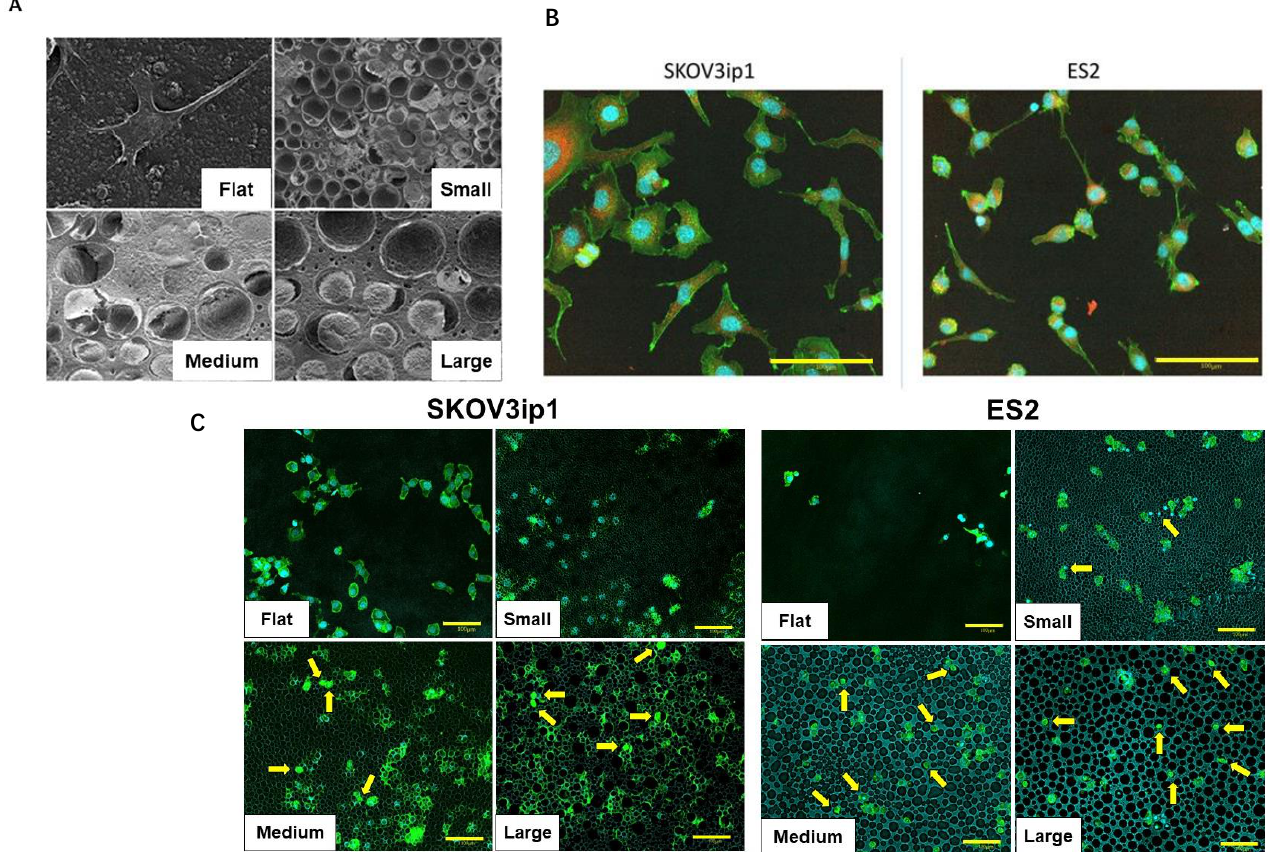
Figure 3. SEM and CLSM images of ovarian cancer cell lines. ( A ) SEM images of SKOV3ip1 cells morphologies on the flat films (Flat), films with a pore size of 5–8 µ m (Small), 8–12 µ m (Medium), and 12–16 µ m (Large). ( B ) CLSM images of SKOV3ip1 and ES2 cells showed the merged staining for the nucleus (blue), actin (green), and vinculin (red). All scale bars (yellow line) are 100 µ m. ( C ) The numbers of cells settled into the pores in SKOV3ip1 and ES2 cells were assessed by CLSM images. The yellow arrow indicates those cells.